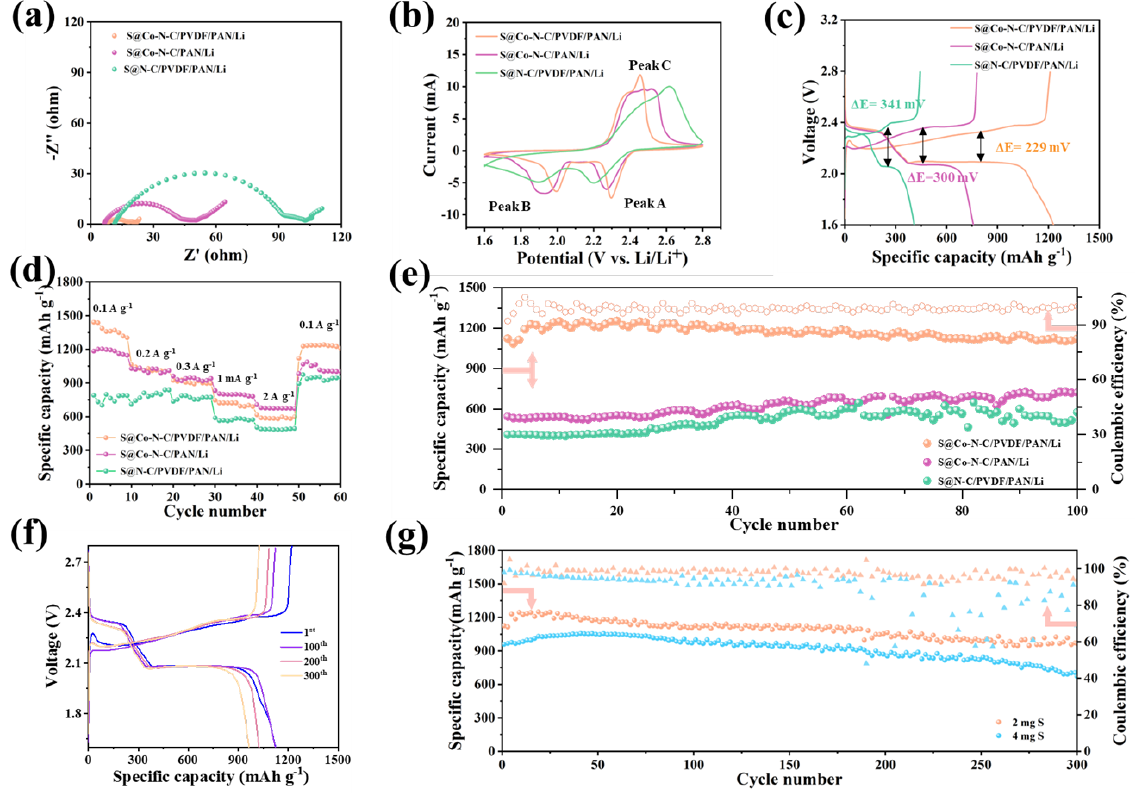
Figure 3. Electrochemical performance of S@Co−N−C/PVDF/PAN/Li, S@Co−N−C/PAN/Li, and S@N−C/PVDF/PAN/Li full batteries. ( a ) EIS curves. ( b ) CV curves. ( c ) Galvanostatic charge and discharge curves; ( d ) Rate performance from 0.15 A g −1 to 3 A g −1 . ( e ) Long−term cycling performance at 1 A g −1 . ( f ) Galvanostatic charge/discharge profile and cycling performance of the S@Co−N−C/PVDF/PAN/Li battery under 2 mg cm −2 sulfur loading at 0.5 mA cm −2 . ( g ) Cycling performance of the S@Co−N−C/PVDF/PAN/Li with an increased sulfur loading at 0.5 mA cm −2 .